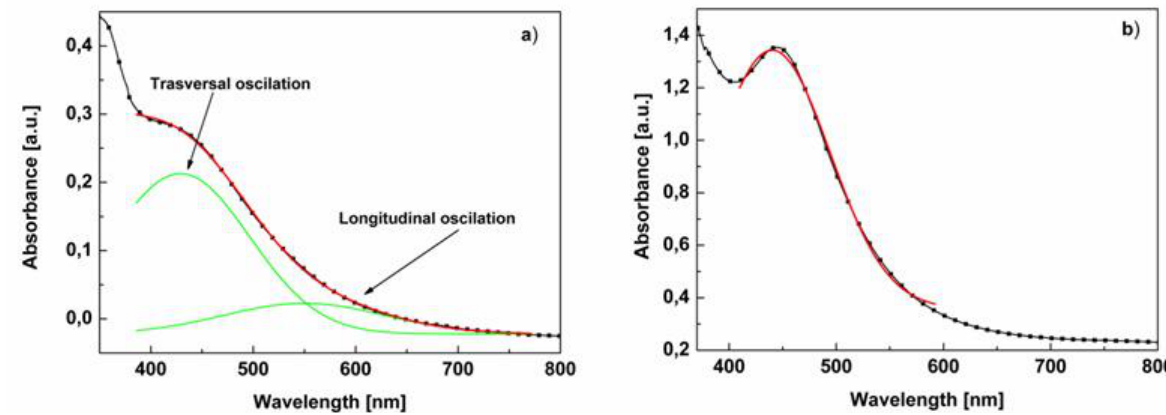
Figure 5. (a) and (b) Extinction spectra of the nanocomposite obtained by thermal decomposition of silver n-dodecyl-mercaptide and by silver cyclohexyl-mercaptide, respectively. Red curves represent the curve fitting to the experimental recorded spectra (black line-symbol) results. The fit was obtained with two Gaussian functions, green curves in (a) and with single Gaussian function in